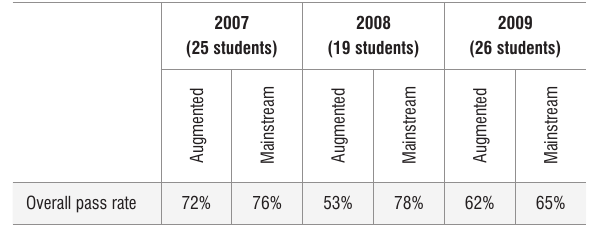
Pass rates for formal assessment Test Two for each cohort